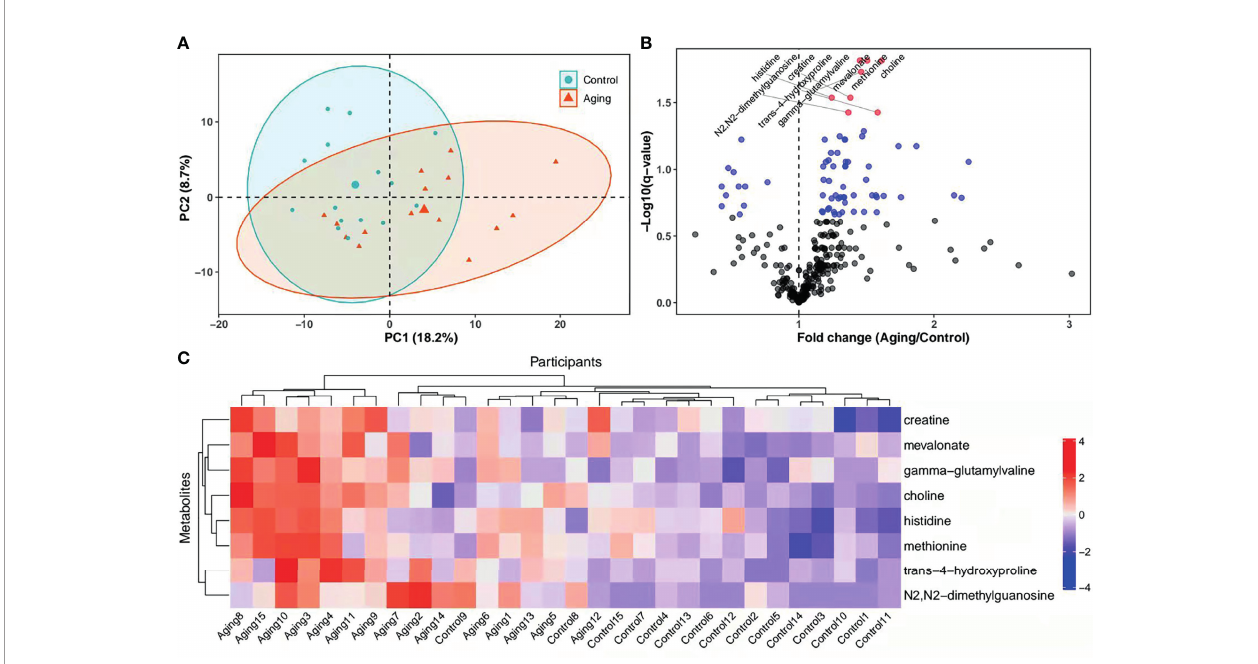
FIGURE 2 | PCA score plots, heatmap and levels of metabolites in different groups. (A) , PCA plots and 2D clustering plots describing the trend of separation between the two groups. The red and green points mean the women with advanced and young ages, respectively. (B) , Levels of each metabolite between the advanced age group and young control group were tested with unpaired Student ’ s t-test. The p -values of t-test were then adjusted with the FDR method to obtain q -values in consideration of multiple comparisons. Fold change was calculated as the ratio of mean of metabolites in the advanced age group to the young control group. In the volcano plot, -log10 ( q -value) ( y-axis ) was plotted against the fold change ( x-axis ). The metabolites with p ≥ 0.05, p < 0.05 and q < 0.05 were shown with black, blue and red points, respectively. (C) , Heatmap of the hierarchical clustering analysis. The selected metabolites ( y-axis ) for each participant ( x-axis ) were presented. Standardized levels of metabolites were shown in different colors. PCA, principal component analysis; 2D, two-dimensional; PC1, fi rst principal component; PC2, second principal